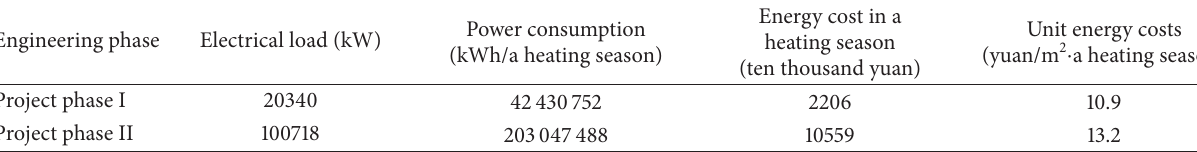
Table 1: Energy costs of RWSHPS.